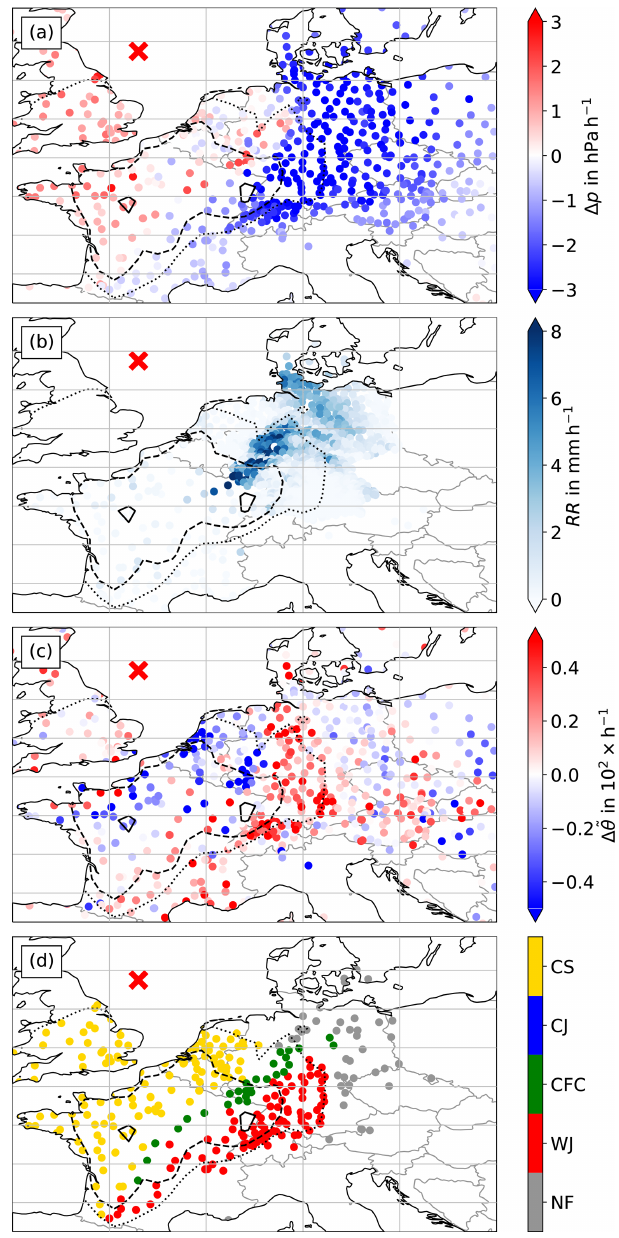
Figure 3. Storm Burglind on 3 January 2018 at 06:00UTC. Scat- tered dots show station observations for (a) (cid:49)p , (b) RR, (c) (cid:49) ˜ θ , and (d) subjectively identified wind features for stations where ˜ v ≥ 0 . 8 and at least three of the five initial parameters are mea- sured (see Sect. 4.1). The contours show the interpolated ˜ v (dot- ted ˜ v = 0 . 8, dashed ˜ v = 1 and solid ˜ v = 1 . 2) to display the regions where the highest winds occurred. The red “x” indicates the cyclone